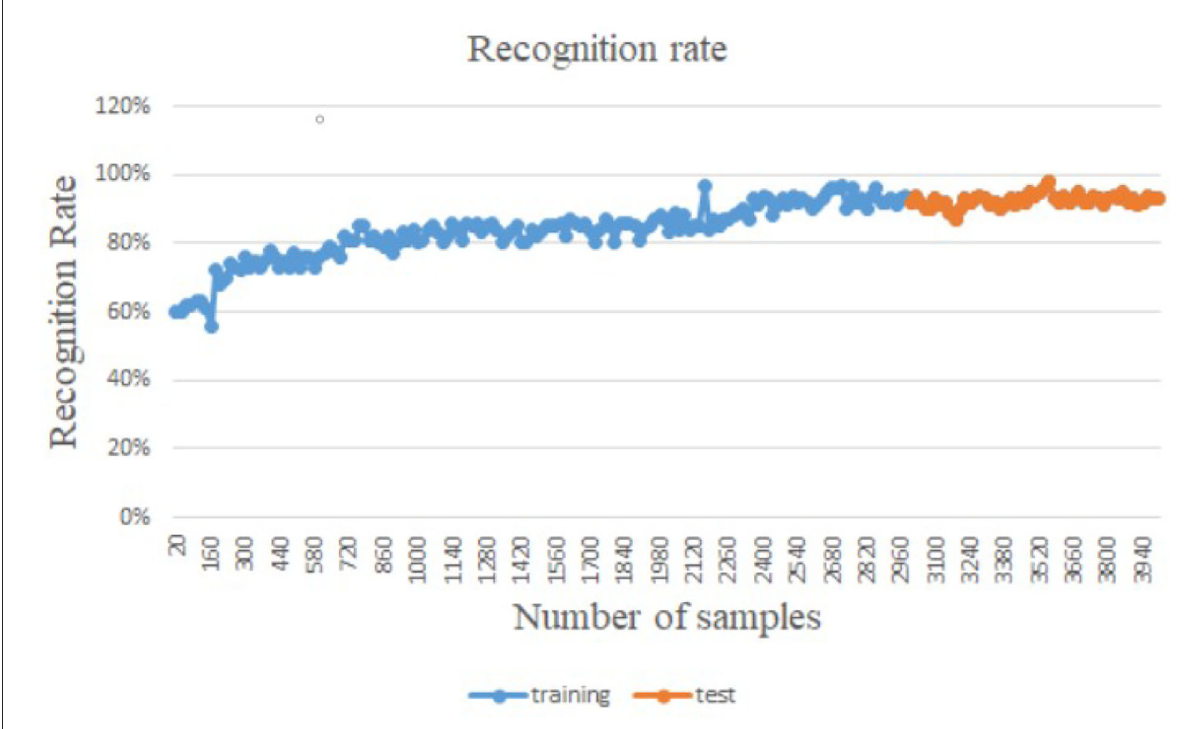
FIGURE5 Faster R-CNN detection results.